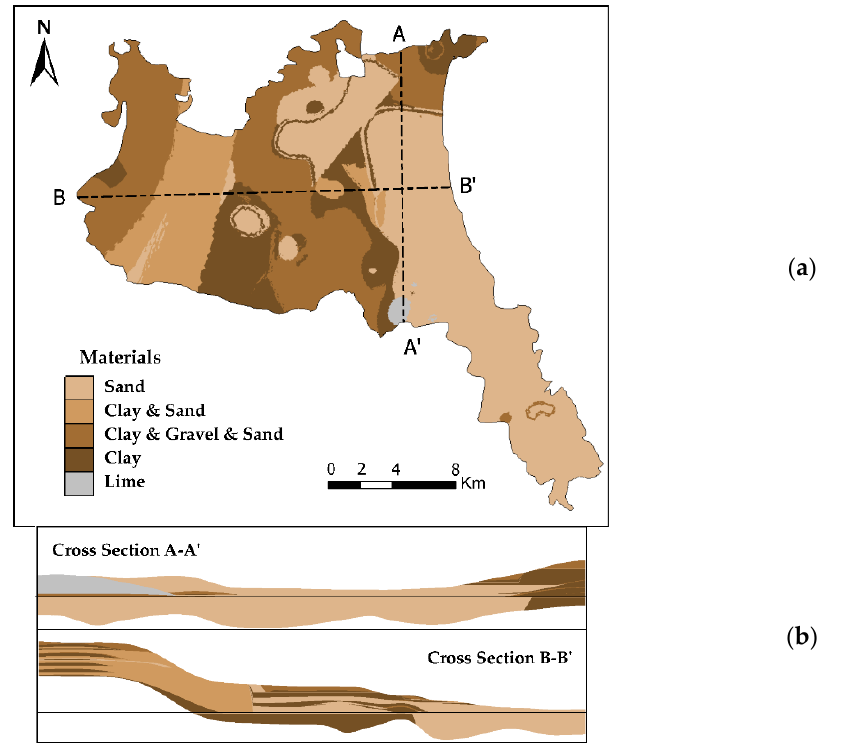
Figure 3. ( a ) Geological Top View and ( b ) Section A ‐ A’ (vertical) and Section B ‐ B’ (horizontal), of the permeable formations of the Almyros aquifer